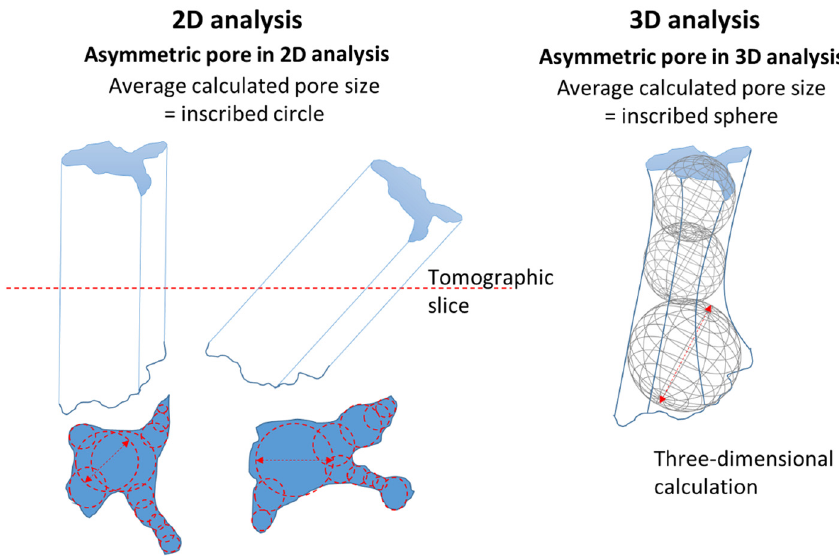
Figure 1: Calculated morphometric parameters of soil pore